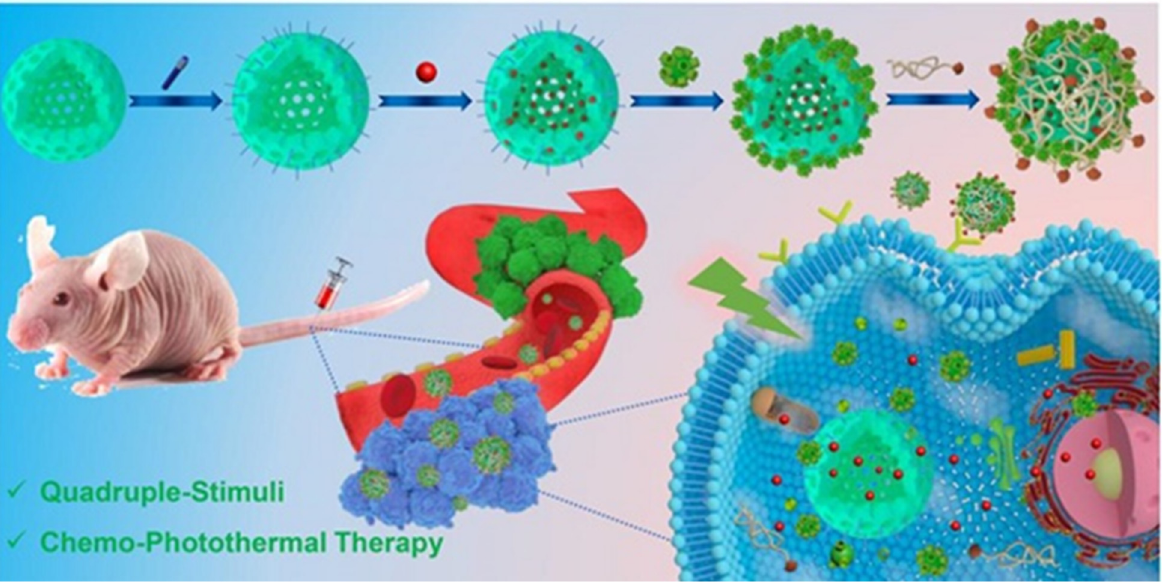
Figure 12. Fa-mPEG@CP5-CuS@HMSN-Py nanoparticles (FaPCH NPs) (reproduced with permission of Ivyspring International Publisher from ref. [82]).